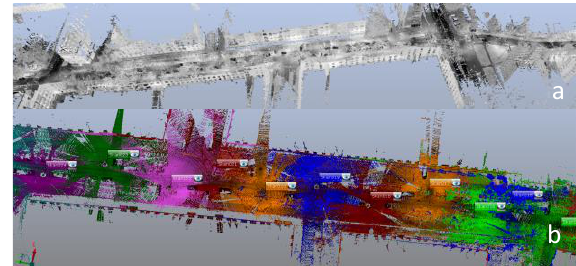
Figure 2. Registered point clouds of the part of the street in a) grey-scale b) with visible separate stations (colored) For point cloud processing common registering algorithms have been used: target-to-target and cloud-to-cloud. The target-to- target method consists of determining the transformation parameters of one scan to another using at least three reference points selected by the operator automatically. Usually as a targets sphere, plane targets and checkerboards are used. Figure 3 presents the examples of target planes used in the experiment.